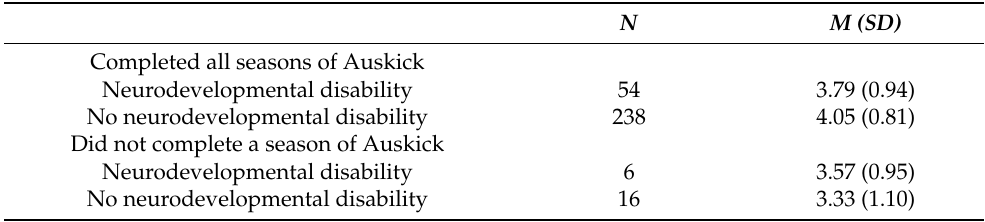
Table 4. Means and standard deviations on child involvement in